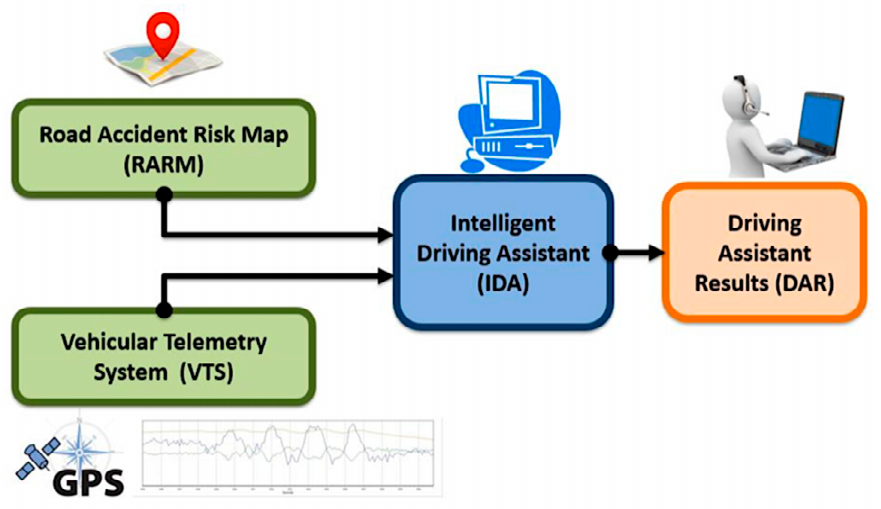
Figure 1. Intelligent Driving Assistant. System